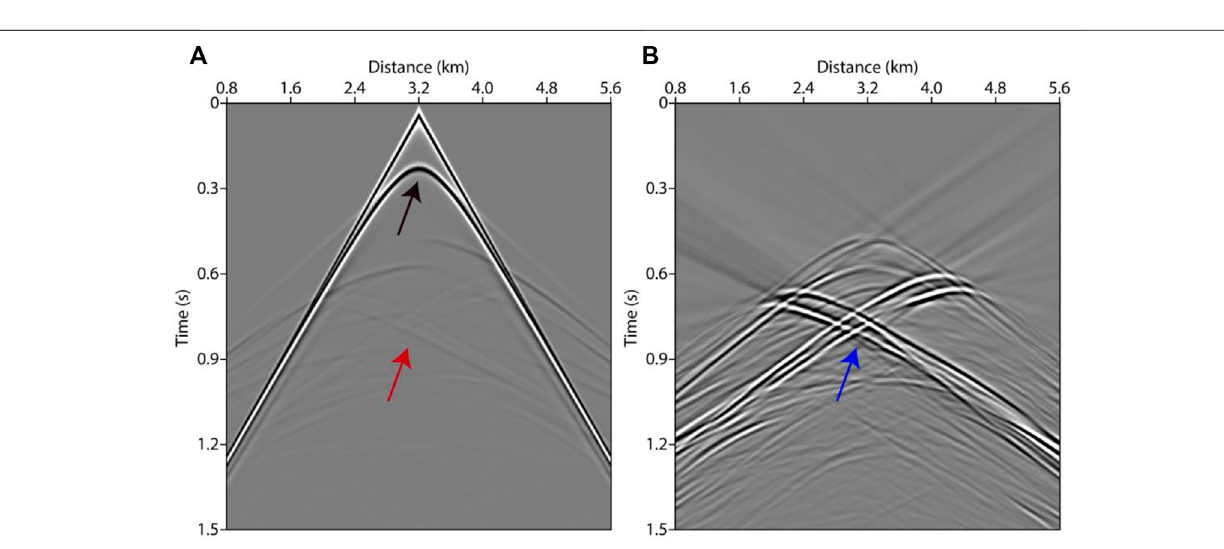
Frontiers in Earth Science |